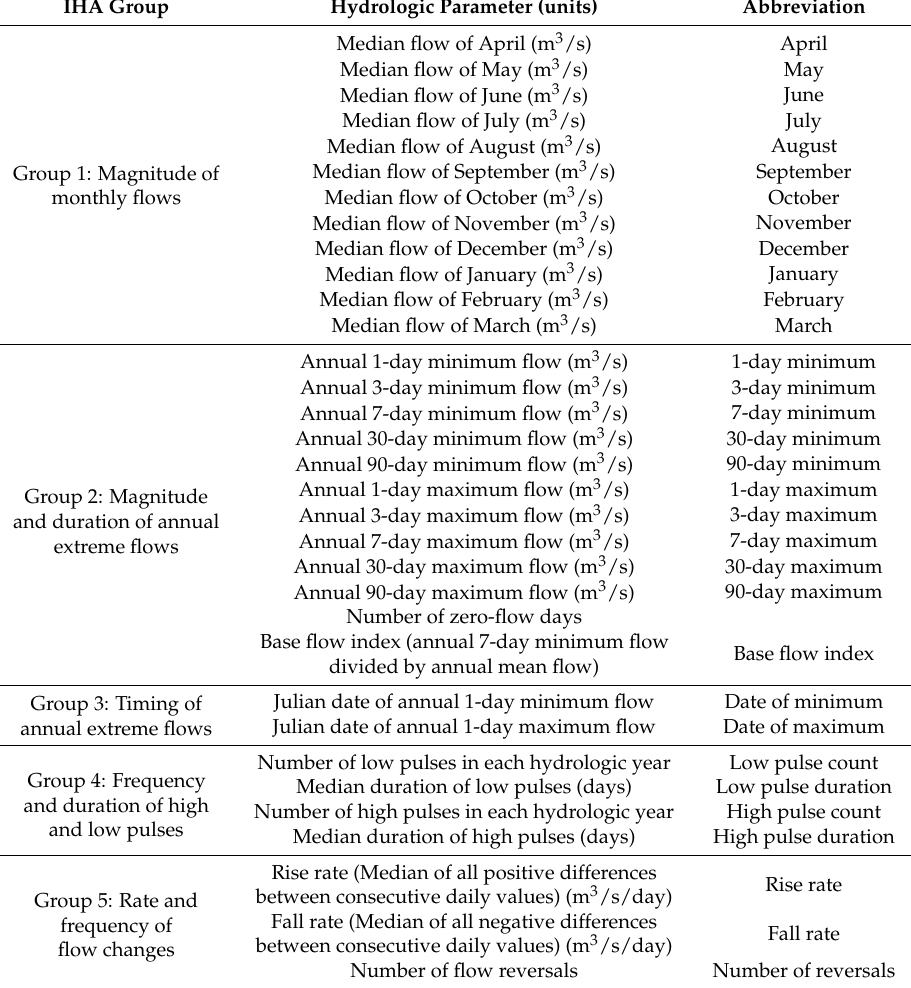
Table 2. Indicators of Hydrologic